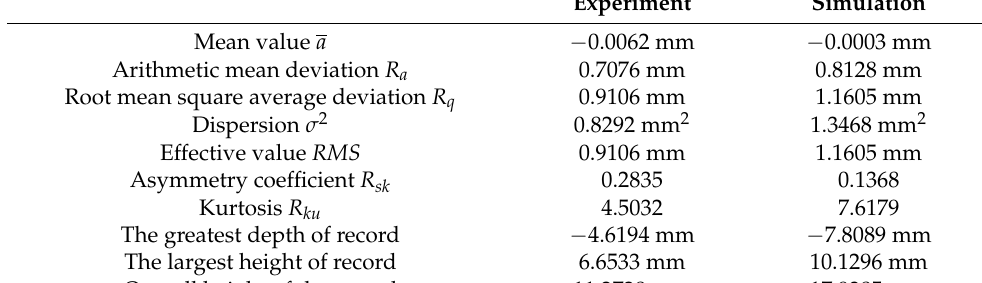
Experiment Experiment